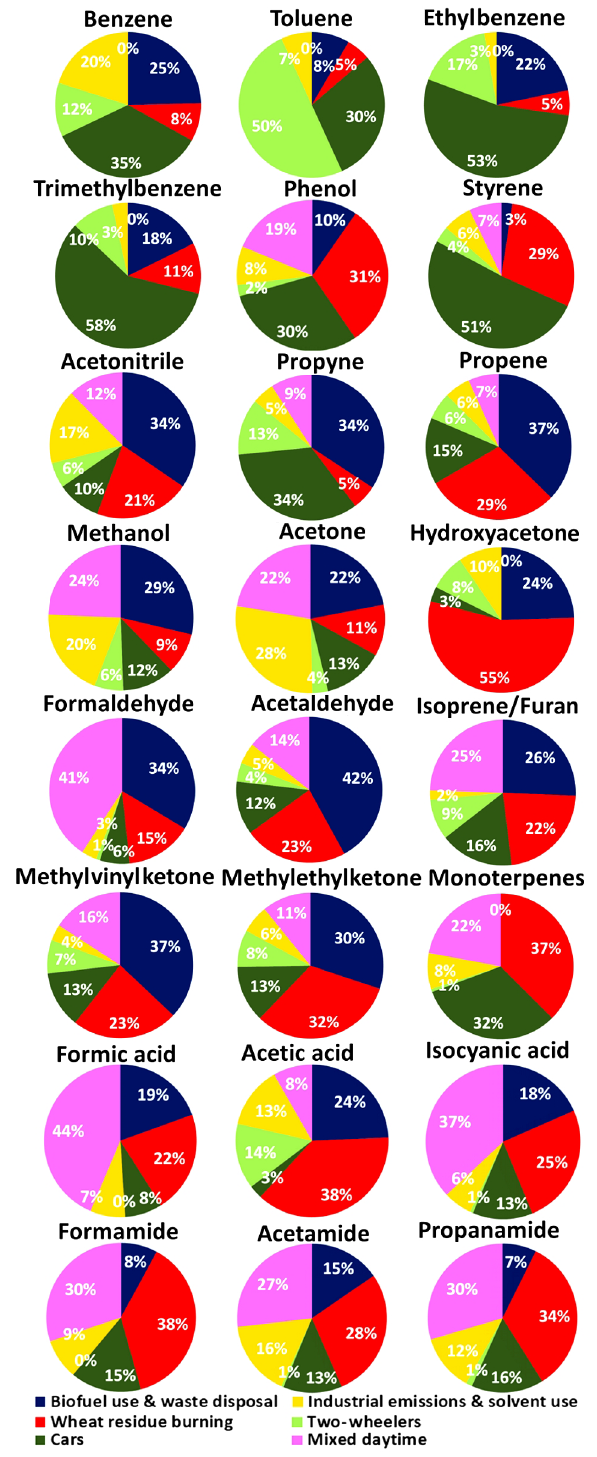
Figure 6. Contribution of individual PMF-derived source factors to the total mass of different